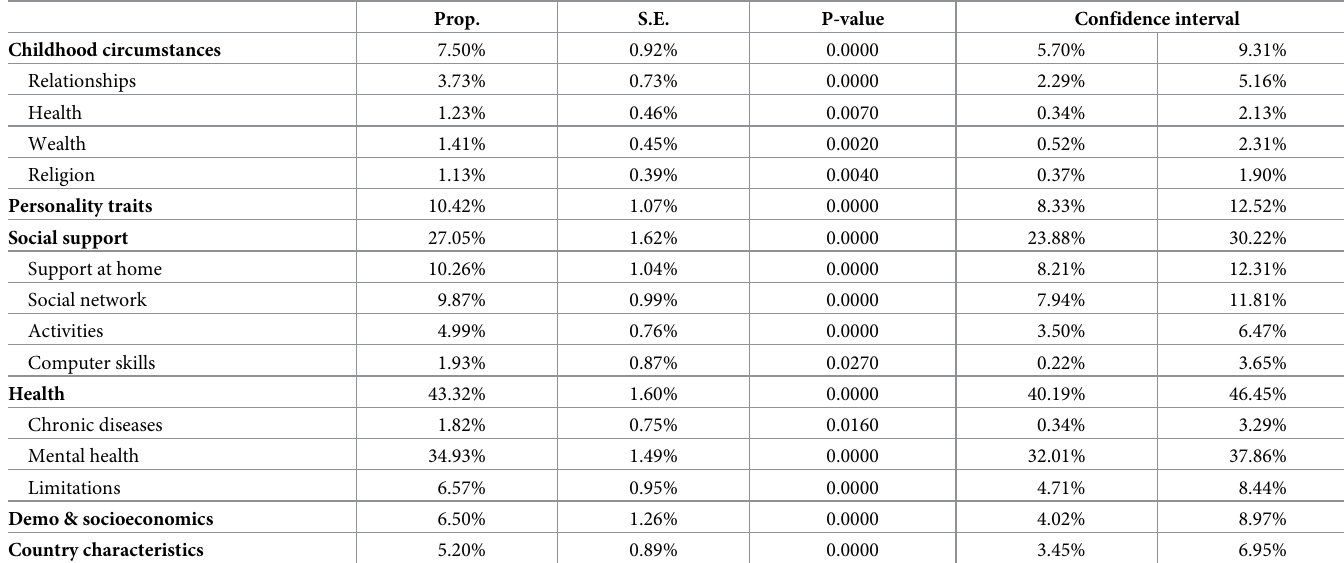
Table 5. Decomposition of the